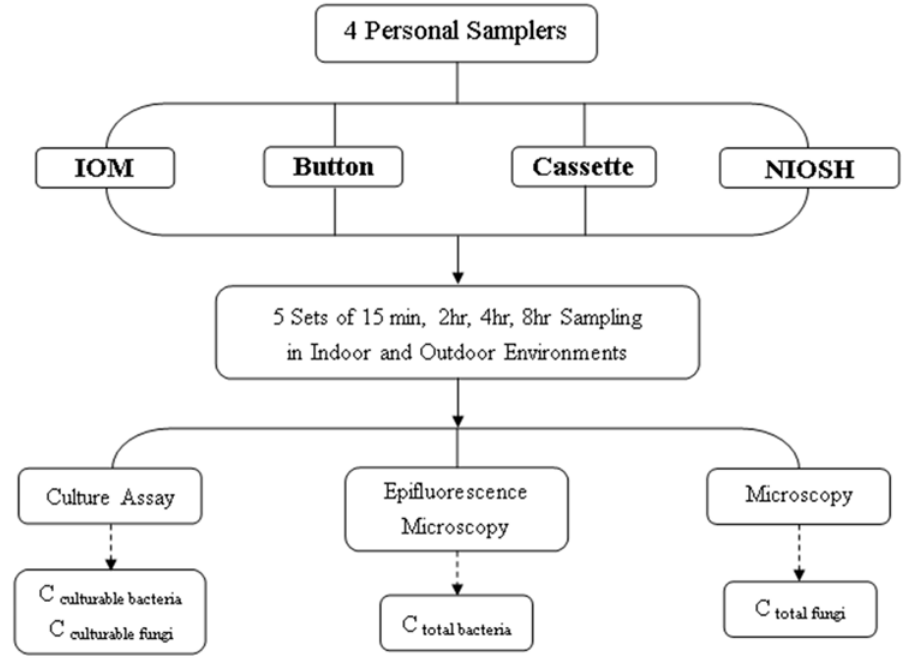
Fig 2. Flowchart for sampler comparison.